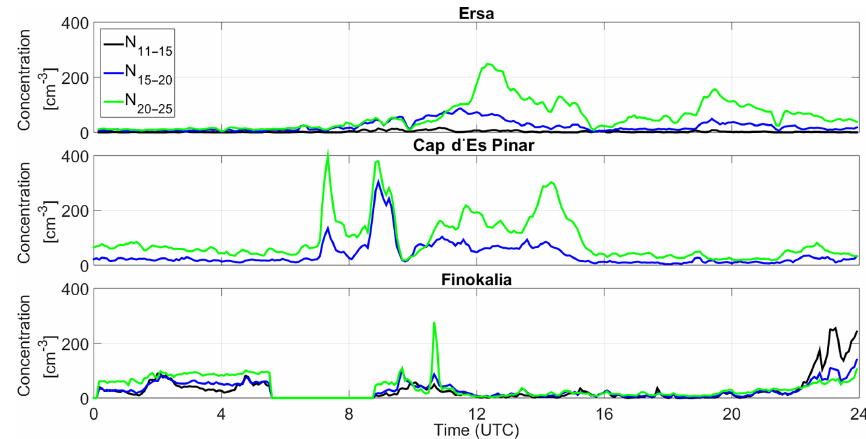
Figure 8. Temporal evolution of the particle concentrations in the size range 11–15nm (black) ( N 11 − 15 ), 15–20nm (blue) ( N 15 − 20 ) and 20–25nm (green) ( N 20 − 25 ) for 9 August event.